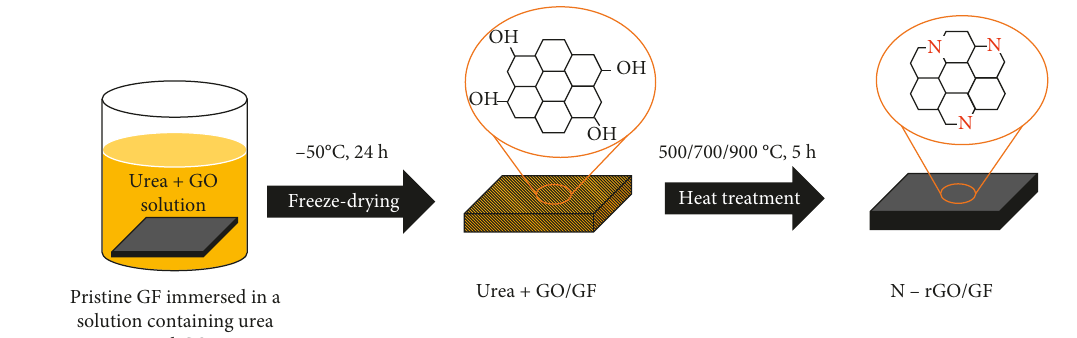
Figure 1: Schematic diagram of the N-rGO/GF fabrication process.